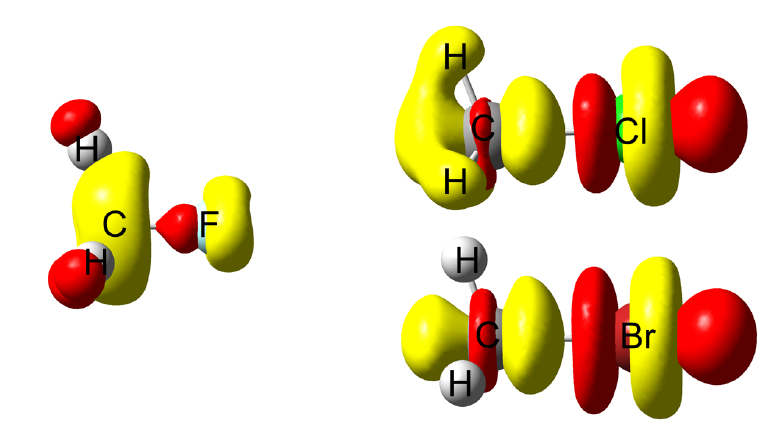
Figure 7. Electron density polarisation in methyl halides when the carbon neighbour to the halogen is perturbed; methyl fluoride (middle left), methyl chloride (upper right) methyl bromide (lower right). δρ > 0 colored in red while δρ < 0 colored in yellow. Isovalue of 2 × 10 − 5 a . u .